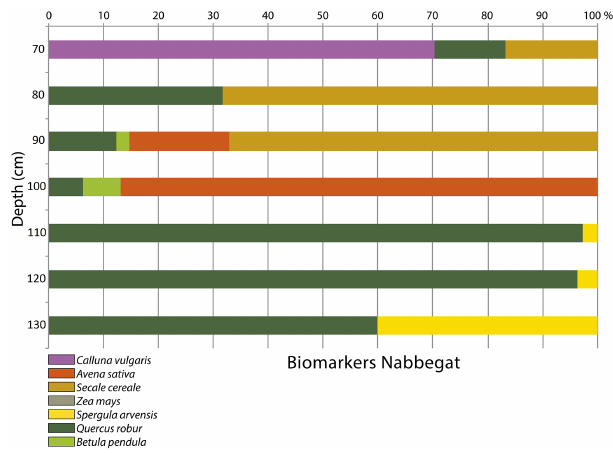
Figure 11. Biomarker diagram Nabbegat.